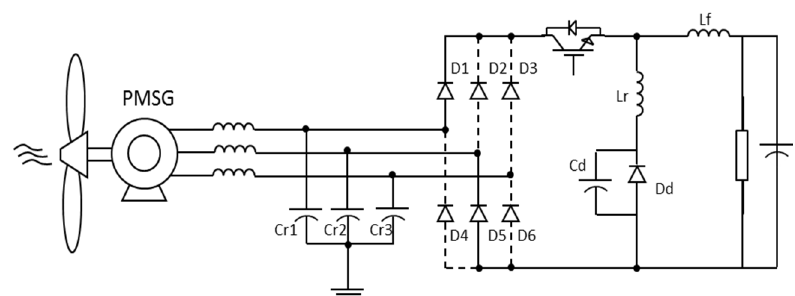
Figure 10. Equivalent circuit: Step 2.